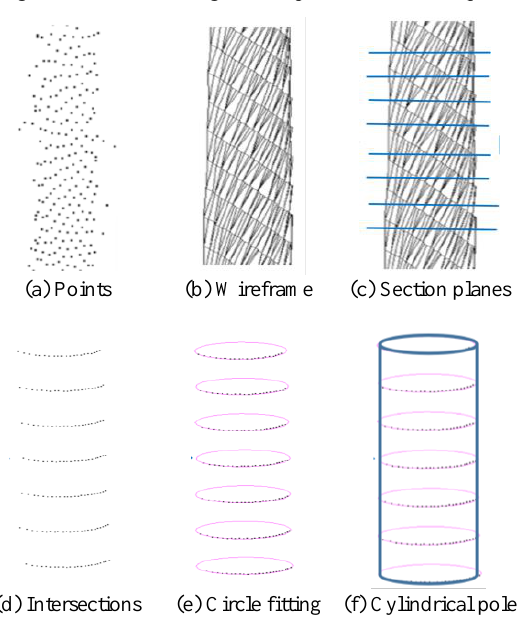
Figure 10. Subdivision guardrail points into unit shapes